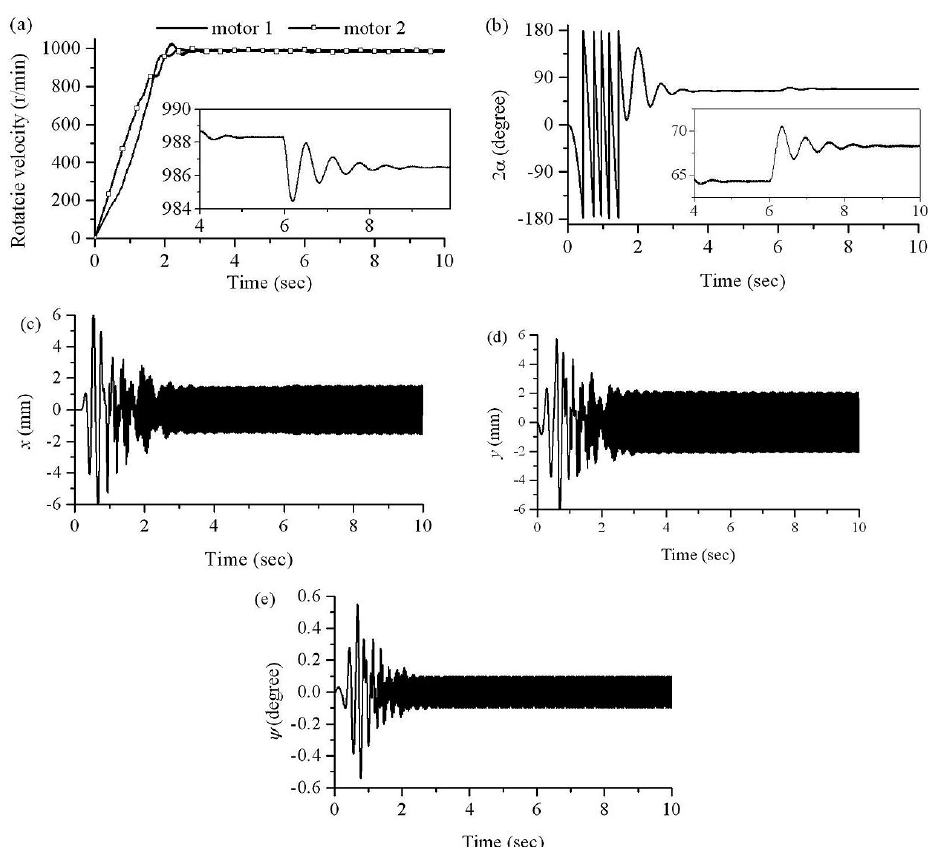
Fig. 3. Results of computer simulation: (a) rotation angular velocities of the two motors; (b) phase difference between the two exciters; (c) displacement in x -direction; (d) displacement in y -direction; (e) angular displacement in ψ